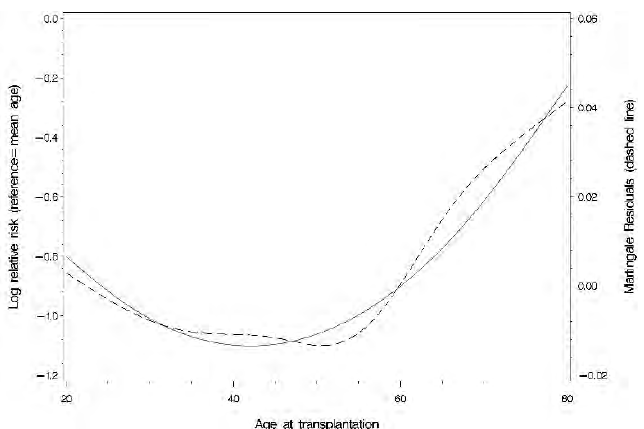
Figure 1: Nonlinear relationship between the probability of graft loss and age at transplantation